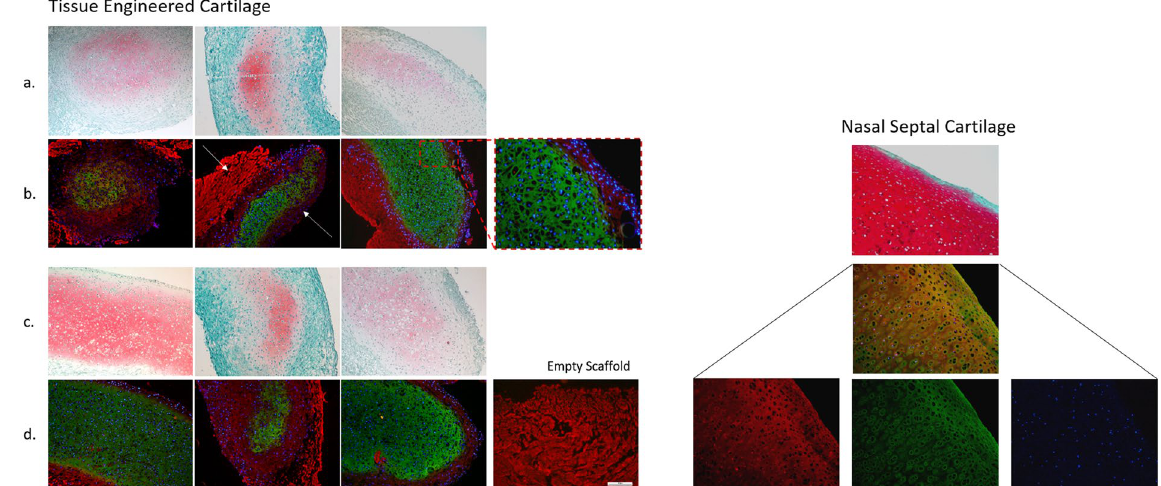
Figure 3. Left: Panel image showing all six donors’ histology ( a , c Fast green, Safranin O and haematoxylin staining showing the distribution of the collagen, GAG and cells respectively. Immunofluorescence ( b , d corresponding to the histology image immediately above) for collagen type I and type II with DAPI for cell nuclei. Right, native septal cartilage histology and immunofluorescence for comparison. Scale bar on bottom right image is 200 μ m. The solid white arrow in B2 indicates the Chondro-Gide scaffold fluorescence for collagen I while the dashed arrow indicates newly formed collagen I produced by the cells and are clearly distinguishable from each other. Breakout image is a 2x zoom if the scaffold surface demonstrating the discrete change from collagen I to collagen II fluorescence.